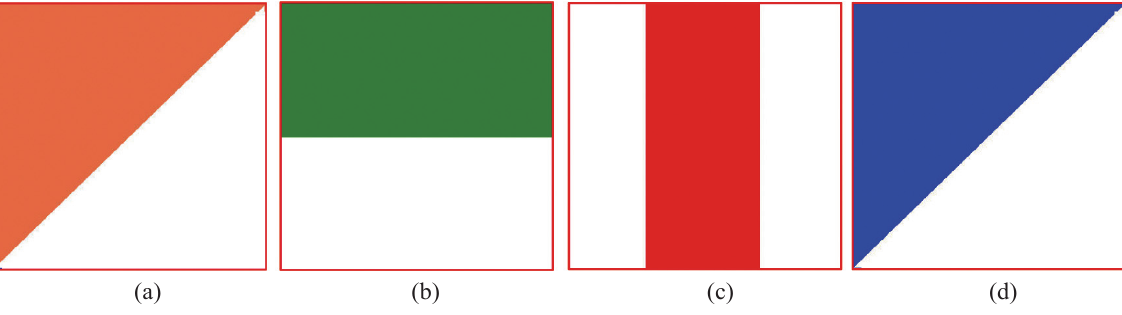
Fig. 2. Fault feature images and test sample feature image (a) Sample 1 (b) Sample 2 (c) Sample 3 (d) Test sample.